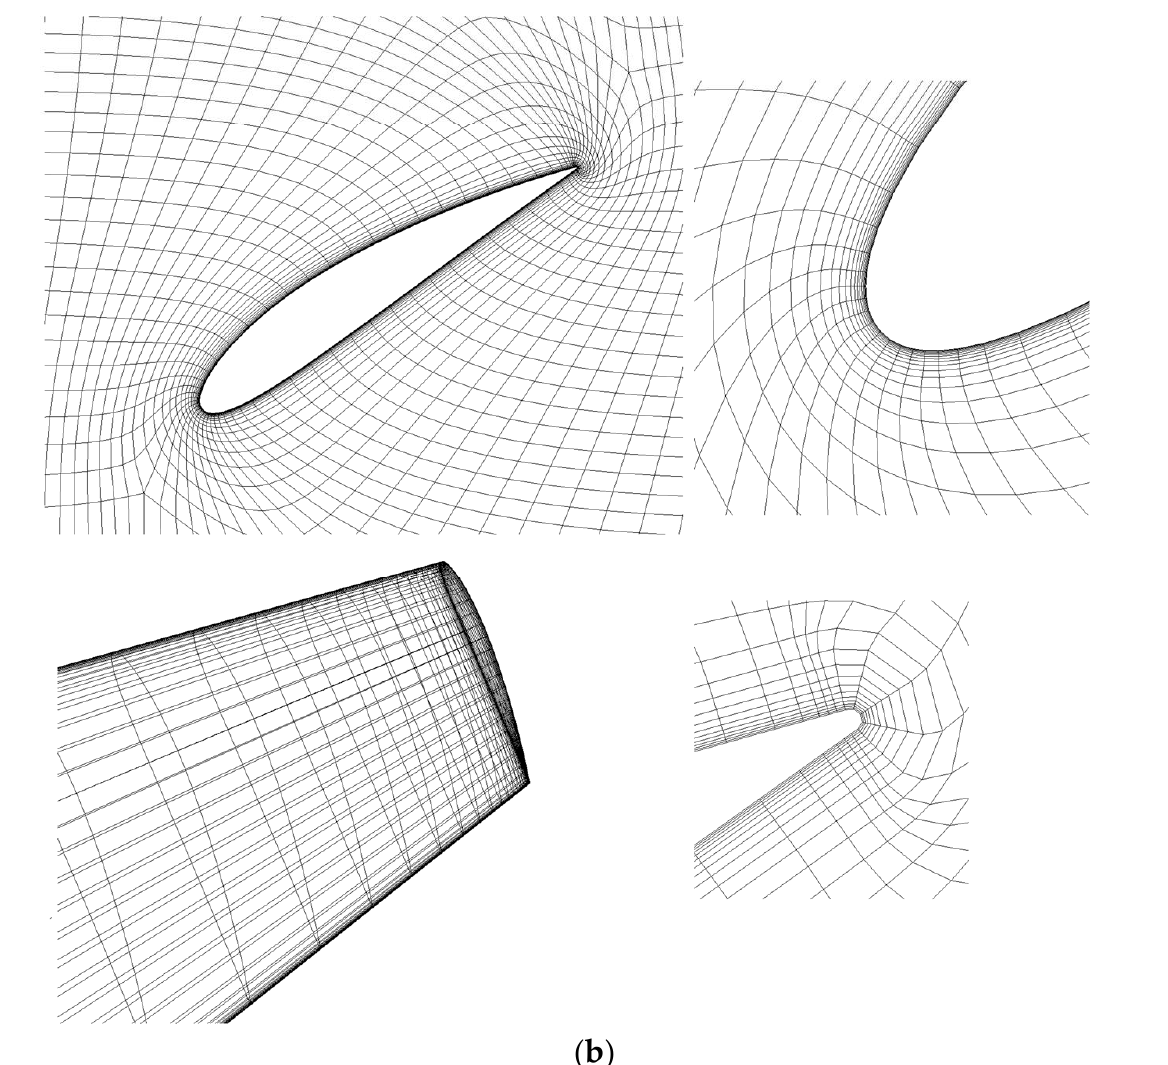
Figure 11. ( a ) Axisymmetric grids and axial velocity contours for various domain sizes for the solo propeller design— 1X [5R-5R-10R], 2X [10R-10R-20R], 3X [15R-15R-30R], 3X-40R extended downstream, 4X [20R-20R-40R] and 4X-50R extended downstream, respectively. ( b ) 1X domain [5R-5R-10R], axisymmetric, 3D domain, blade without hub nose, airfoil LE and TE